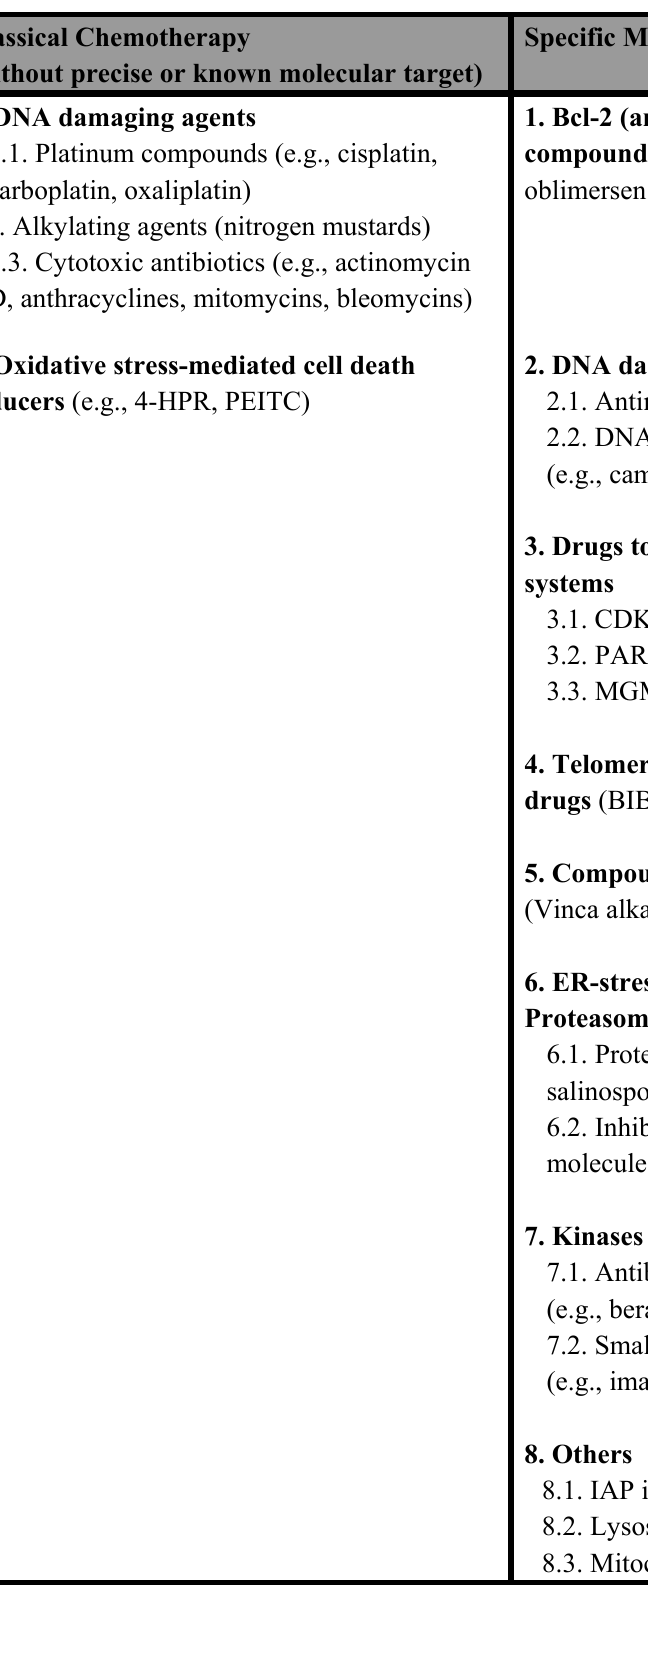
Table 3. Classification of antitumoral drugs according to their cellular